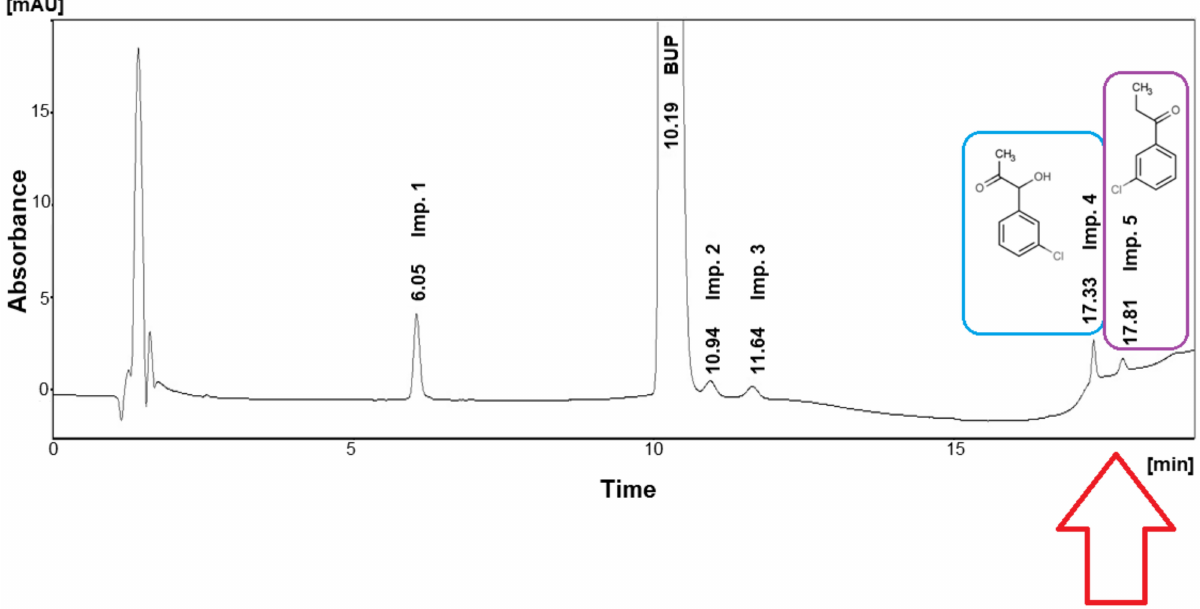
Figure 1. Chromatogram corresponding to a standard solution containing 400 µ g/mL BUP spiked with all impurities at their specification limits. The red arrow depicts the chromatographic area and the related impurities with their structures of the process described